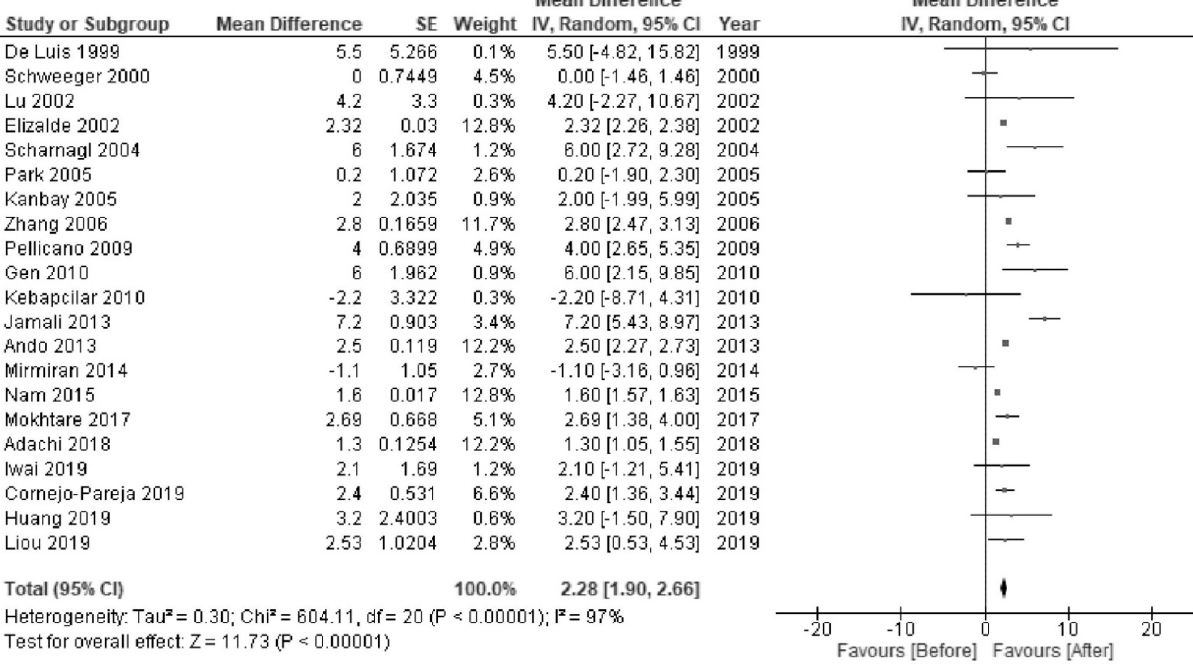
Figure 3. Forest plot of the mean changes in triglyceride levels before and after Helicobacter pylori eradication.